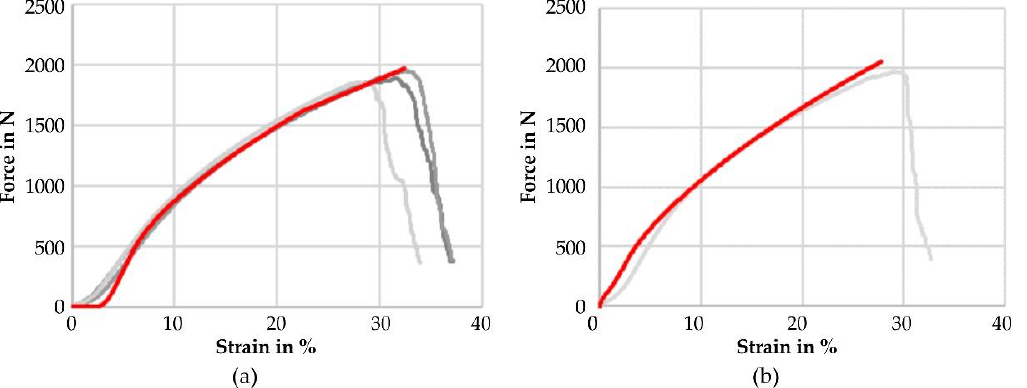
Figure 11. Simulation results of gradient fabric GW2: displacement of the warp yarns at different total strain values: ( a ) 10%, ( b ) 20%, and ( c ) 30%.